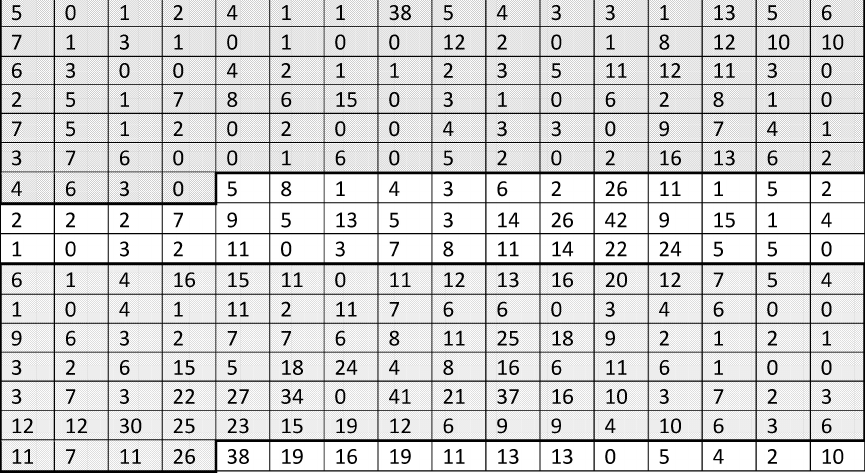
Figure 5. Two data sets of N = 100 trap counts of P. melanarius ; each have been extracted from a single original data set of N = 256 trap counts collected by Alexander et al. (2005). Data Set I has been taken from the upper half of the original data table, and Data Set II has been taken from the lower half of the original data table. Both data sets are shadowed in